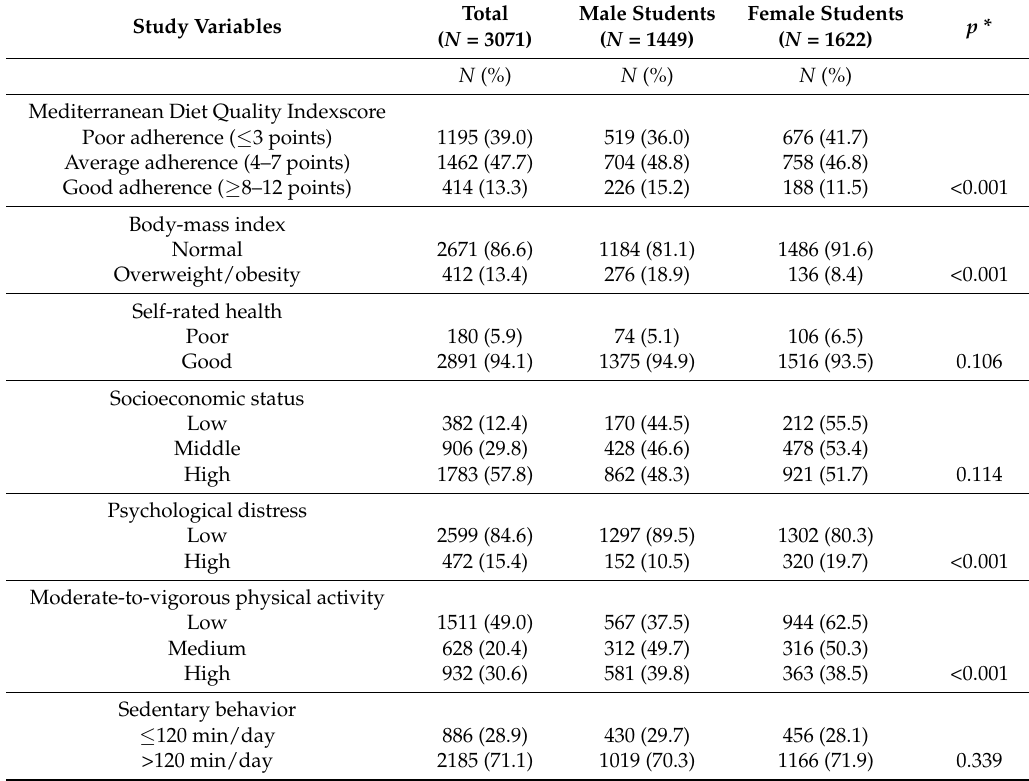
Table 1. Basic descriptive characteristics of the study